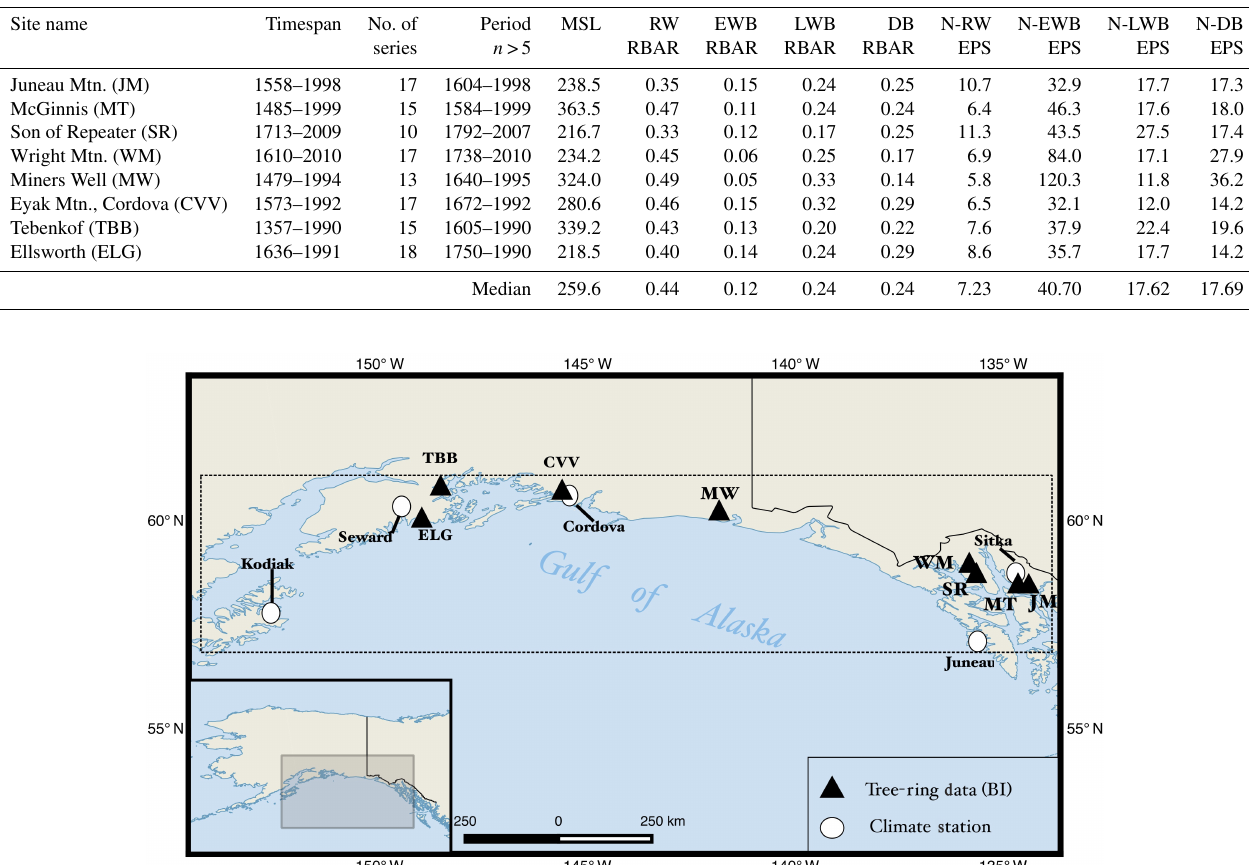
Table 1. Metadata information for the eight GOA sites used in the study. The sites are ordered from east to west (see Fig. 1). All principal component analyses (PCAs) and related analyses were performed on the 1792–1990 period for which there is replication of at least five series for all eight sites. Tree-ring data were detrended using a 200-year spline for these signal strength analyses. The final four columns denote the number of series needed to attain an EPS of 0.85 (Wigley et al., 1984).